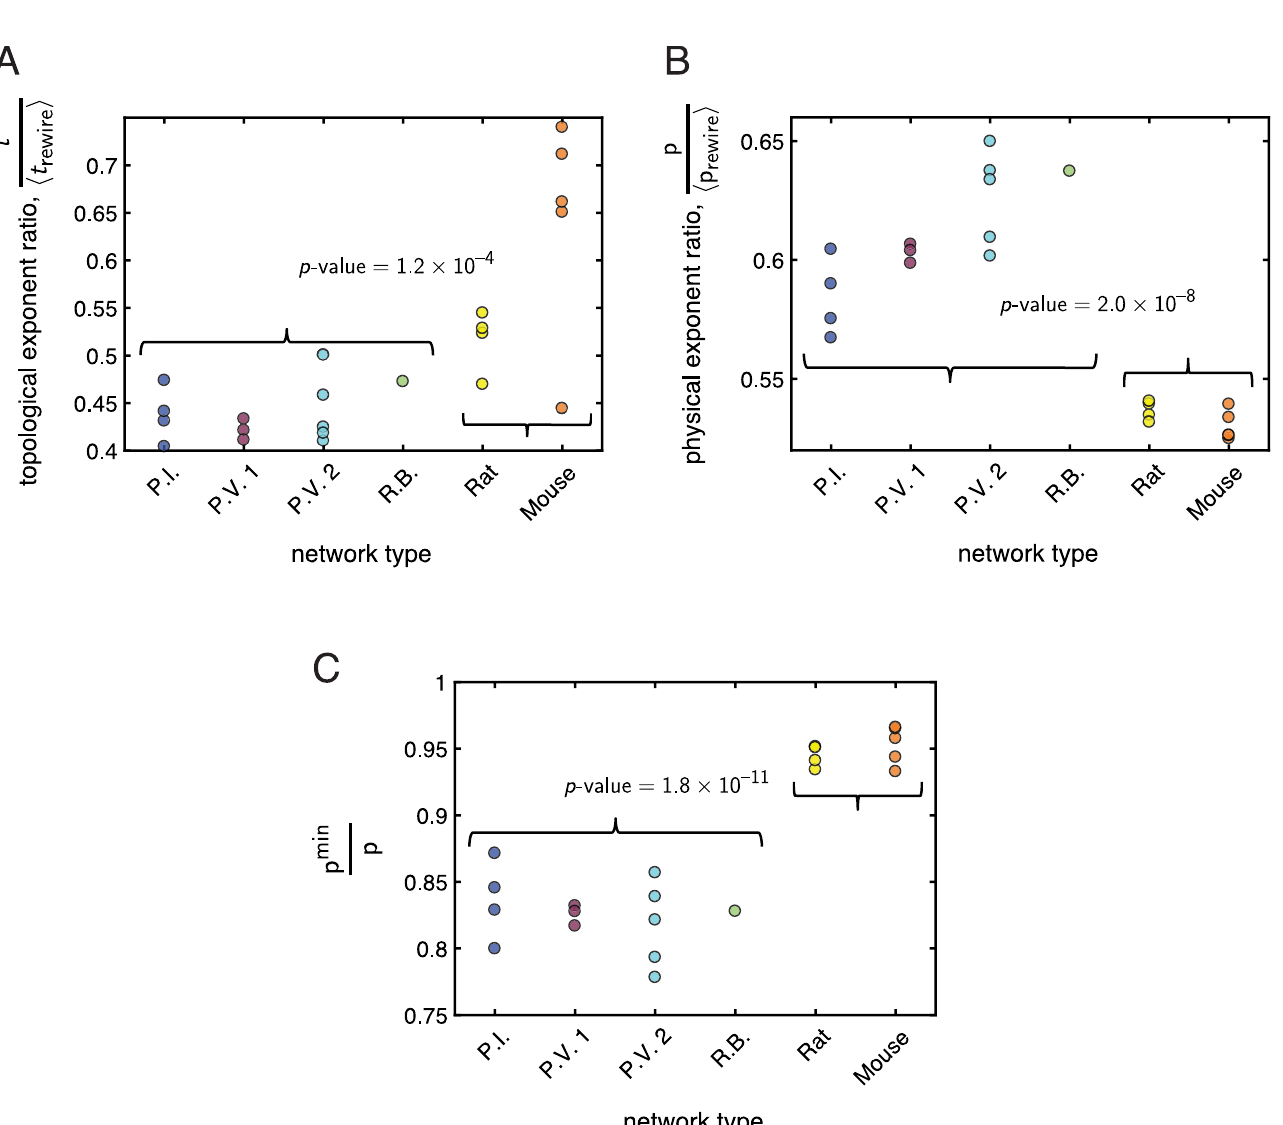
Fig 6. Comparison of Rentian scaling analysis in the mycelial networks and vasculature networks. In each panel, the x -axis labels the kind of network, with the curly braces grouping the mycelia (first 4 networks) and the vasculature (last 2 networks). The y -axis measures the value of a given property for each network. A p -value is displayed if there was a statistically significant difference (as determined by a two-sample t -test) in the mean value of the given property between the population of mycelial networks and the population of vasculature networks. (A) The normalized topological Rent exponent ~ t ¼ t = h t smaller in the population of mycelial networks compared to the population of vasculature networks. (B) The normalized physical Rent exponent ~ p ¼ p = h p was significantly larger in the population of mycelial networks compared to the population of vasculature networks. (C) The ratio p min / p of the theoretical minimum physical Rent exponent to the true physical Rent exponent was signficantly smaller in the population of mycelial networks compared to the population of vasculature networks. See the main text for more details on each measure.